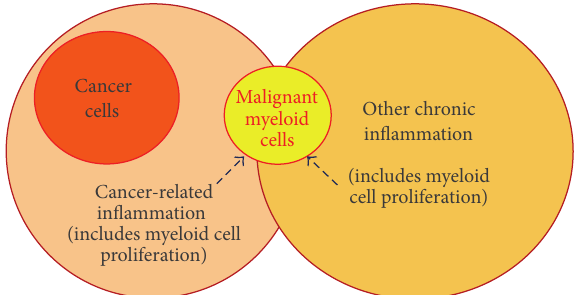
Figure 2: Increased risk of myeloid malignancy in case of chronic inflammation. Chronic inflammation may be related to solid cancer or to other causes (infectious, toxic, and physical). In all cases the immune response includes an increased stimulation of the production of myeloid cells, with the associated increased risk of DNA alteration in dividing progenitor cells. Over the years, a myeloid progenitor may acquire a defect in a gene critical for survival or proliferation ( MPL , JAK2 , and CALR ?) and a MPL -, JAK2 -, or CALR -mutated malignant clone may expand and lead to a MPN. Other mutations providing a mild growth advantage ( TET2 , IDH1/2 ?) may occur before or after the MPL , JAK2 , or CALR mutations.Inthecaseofinflammationrelatedtosolidcancer,cancer cells and the inflammatory cytokines they produce likely affect immune